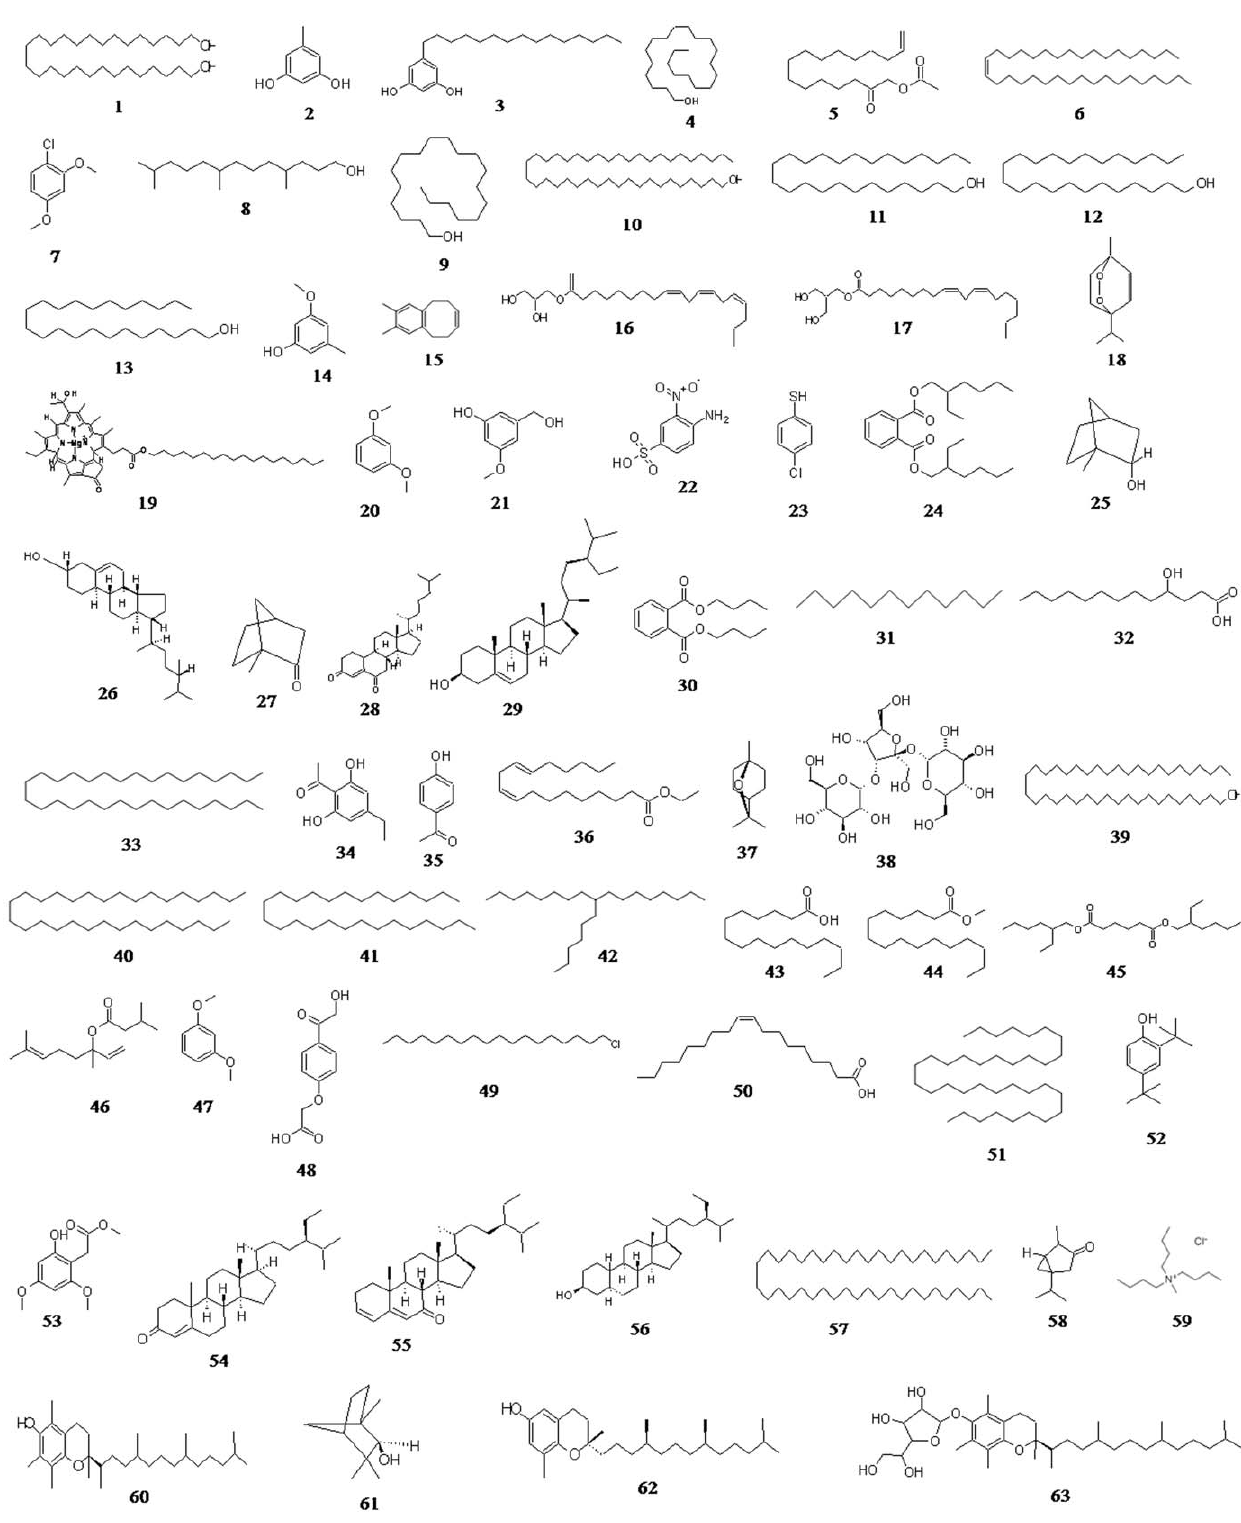
Figure 8. Phyto-chemotypes identified in different root extracts of R.imbricata . 1: 1,30-triacontanediol; 2: 1,3-benzenediol, 5-methyl; 3: 1,3- benzenediol, 5-pentadecyl; 4: 13-docosen-1-ol, (Z); 5: 13-tetradecen-1-ol acetate; 6: 17-pentatriacontene; 7: 1-chloro-2,4-dimethoxybenzene; 8: 1- dodecanol, 3,7,11-trimethyl; 9: eicosen-1-ol, cis-9; 10: 1-hentetracontanol; 11: 1-pentacosanol; 12: 1-tetracosanol; 13: 1-tricosanol; 14: 3-methoxy-5- methylphenol; 15: 7,8-dimethylbenzocyclooctene; 16: 9,12,15-octadecatrienoic acid, 2,3-dihydroxypropyl ester, (Z,Z,Z); 17: 9,12-octadecadienoic acid (Z,Z)-, 2-hydroxy-1-(hydroxymethyl)ethyl ester; 18: ascaridole; 19: bacteriochlorophyll-c-stearyl; 20: benzene, 1,3-dimethoxy; 21: benzenemethanol, 3-hydroxy-5-methoxy; 22: benzene sulfonic acid, 4-amino-3-nitro; 23: benzenethiol, 4-chloro; 24: bis(2-ethylhexyl) phthalate; 25: borneol; 26: campesterol; 27: camphor; 28: cholest-4-ene-3,6-dione; 29: stigmast-5-en-3-ol, (3 b ,24S); 30: di-butyl phthalate; 31: 1-dodecane; 32: